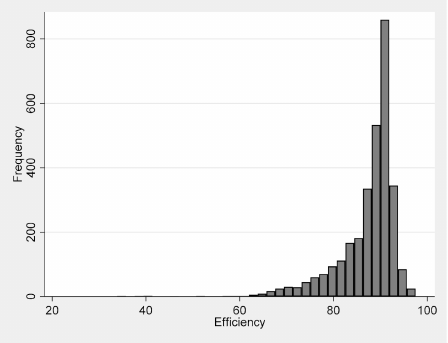
Figure 2. Histogram of GHG Emission E ffi ciency